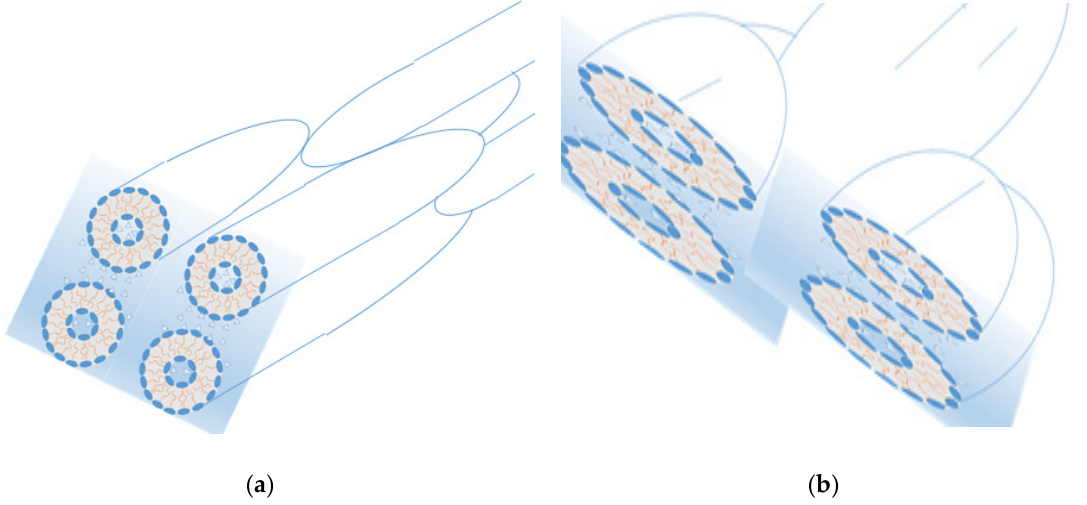
Figure 5. Systems of rod-like bilayers with long-range orientation (nematic structure) forming particles of oval and thread-like character, and disc-like bilayers forming particles of oval character with a smectic stratified structure by prevailing weak hydro-attraction. System of prevailing weak hydro-attraction. ( a ) The system of rod-like bilayers; ( b ) the system of disc-like